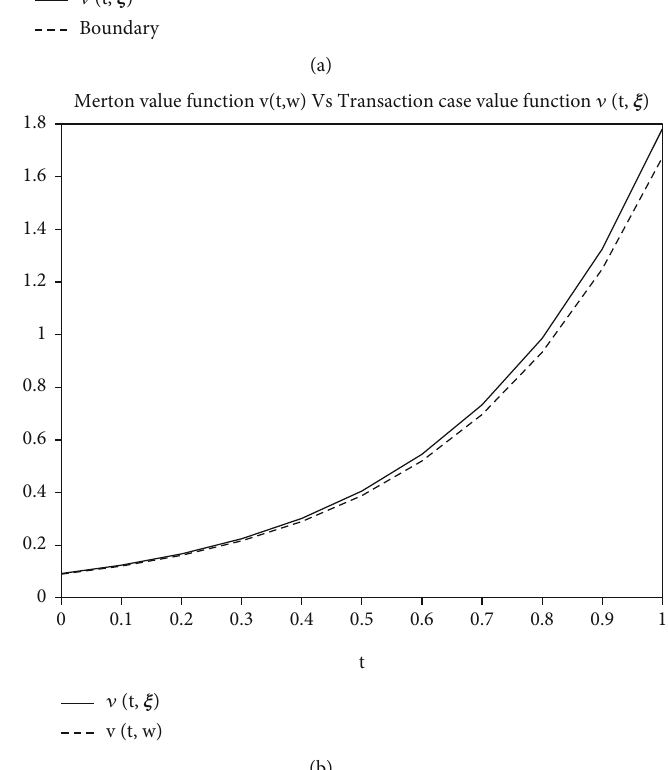
= 0 : 02, μ = 0 : 2, σ = 0 : 25, 1 1 2